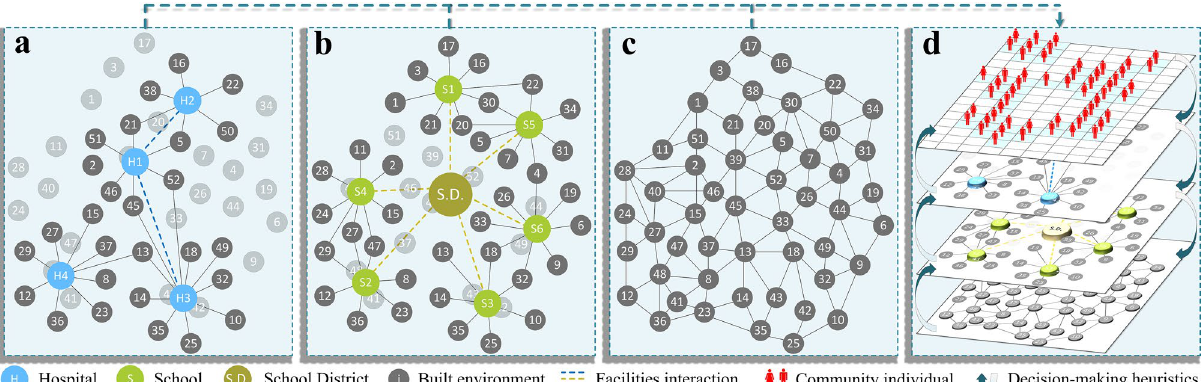
Figure 6. Components of the agent-based model: ( a ) healthcare system including its supporting infrastructure, ( b ) education system comprising of schools, school district as a main administrative component, and the supporting infrastructure, ( c ) the community built environment containing infrastructure, building, and suppliers, and ( d ) interaction between community individuals (sub-agents), healthcare and education facilities (main agents), and the built environment (supporting agents) in the decision-making heuristics